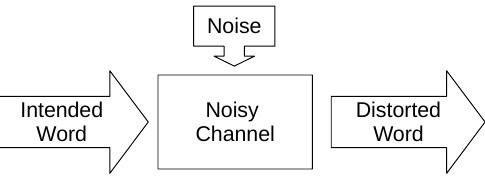
Figure 3. Word distorted by noisy